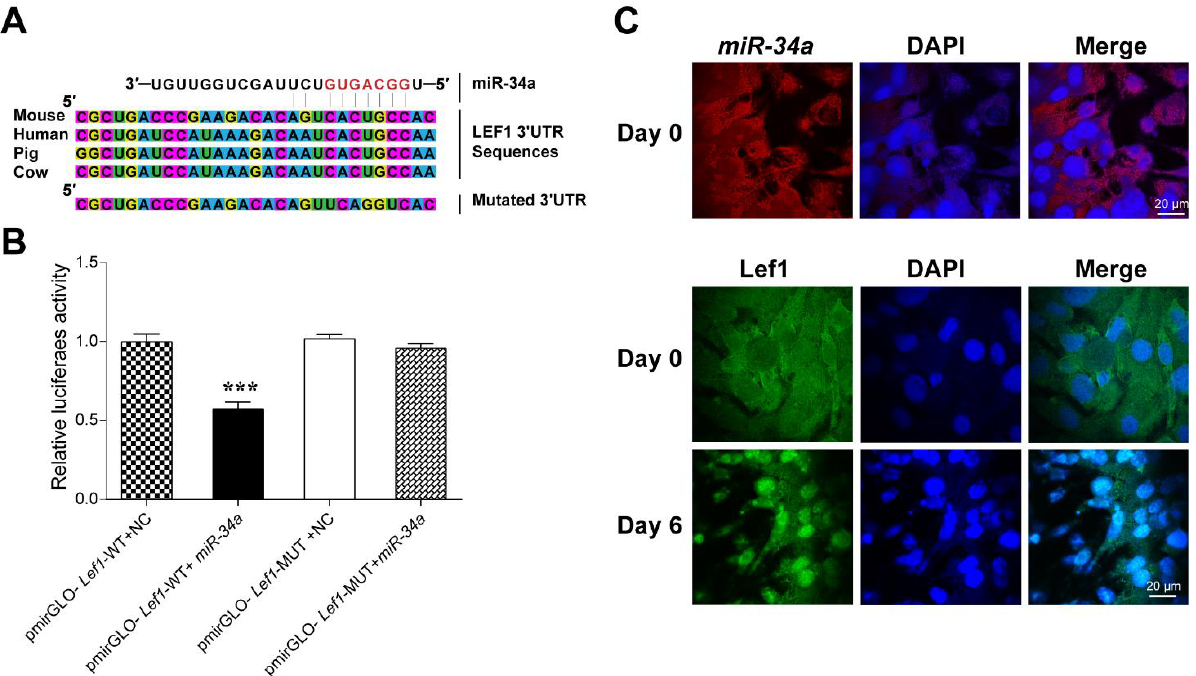
Figure 5. The targeting relationship and cellular location of miR-34a and Lef1 . ( A ) The targeting relationship predicted with TargetScan and Starbase websites. ( B ) Luciferase reporter assay was performed to detect luciferase activity in HEK293 cells co-transfected with pmirGLO- Lef1 -WT or pmirGLO- Lef1 -MUT reporter and miR-34a mimics or NC. RNA FISH ( C ) indicated that miRA-34a was located in cytoplasm. Lef1 was transferred into the nucleus with the differentiation of 3T3-L1-derived adipocytes (0 d – 6 d). *** p < 0.001 versus NC ( n = 3).